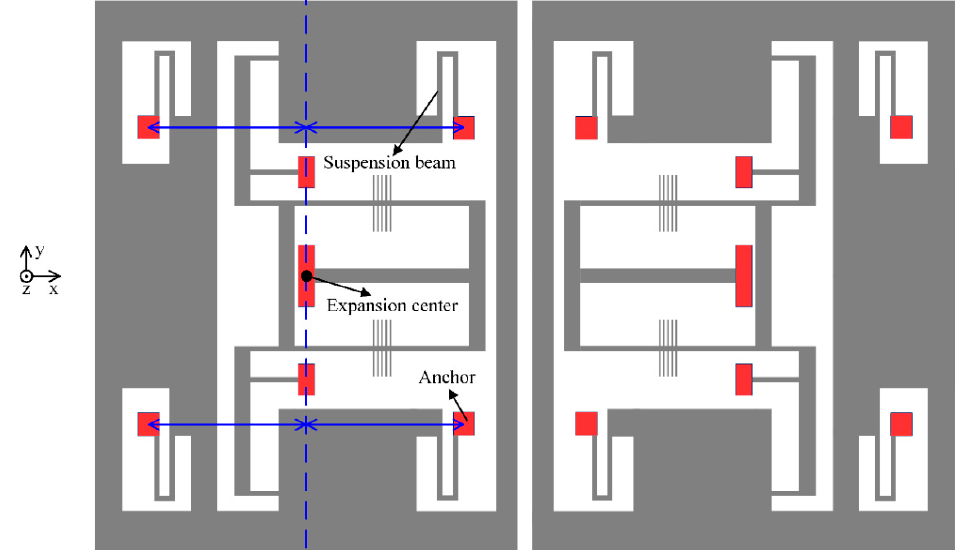
Figure 2. The schematic structure with optimized anchor locations.